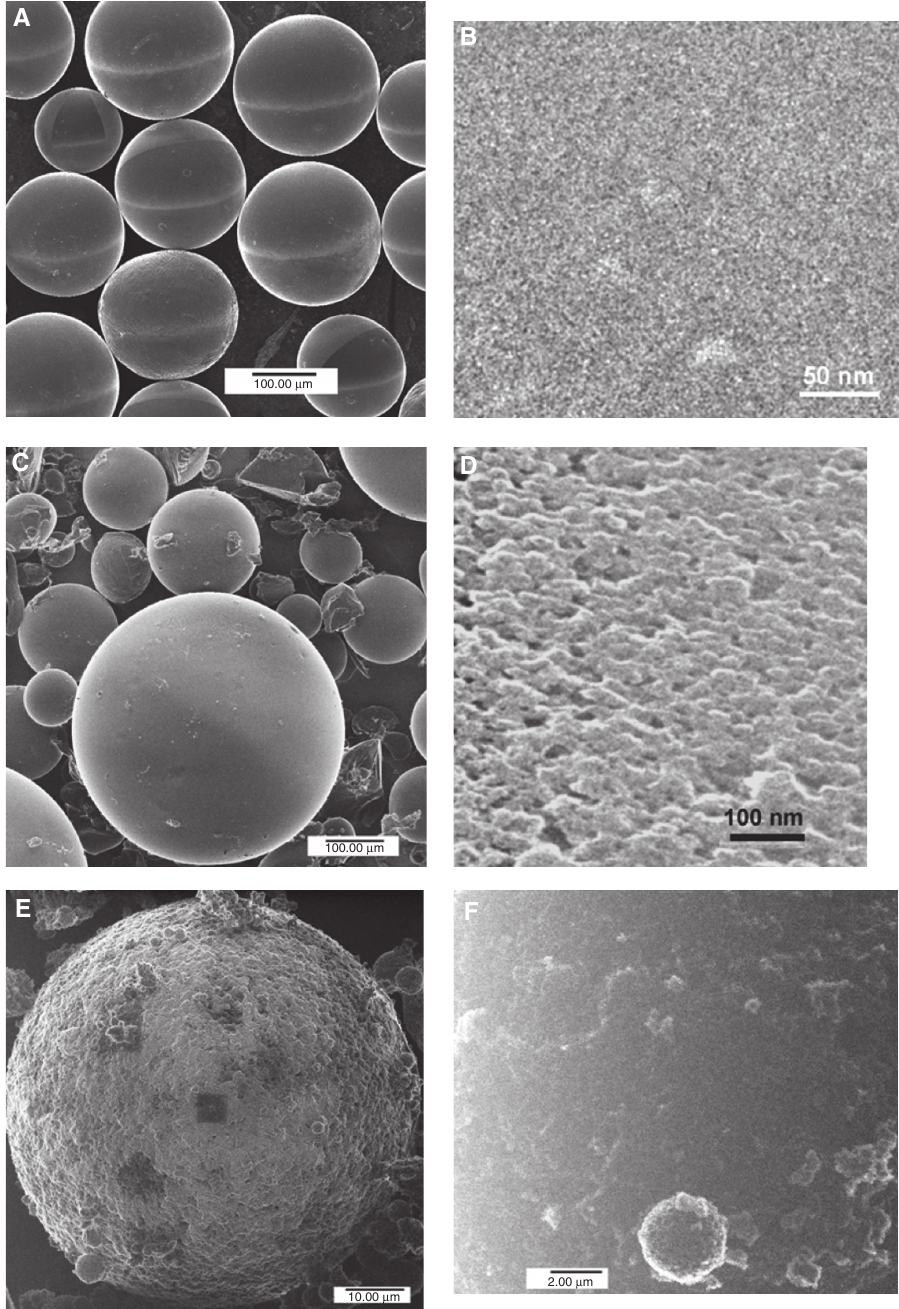
Figure 6 HIM images of nanoporous polystyrene beads prepared via suspension polymerization with three different porogens: toluene (A, B), n-heptane (C, D), and Span-80 (E, F) (see explanation in the text). Low-resolution images (left) give insight in the bead’s size distribu- tion and surface roughness, while high-resolution images (right) allow visualization and direct measurements of the pore size and pore size distribution not available in other microscopy